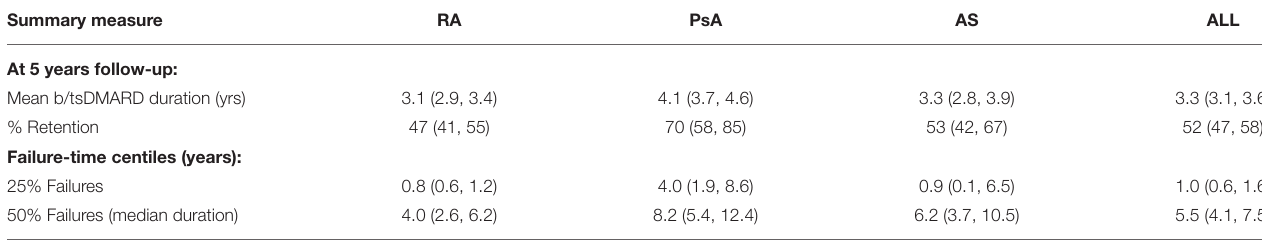
TABLE 3 | Summary measures from mean b/tsDMARD retention curves for rheumatoid arthritis (RA), psoriatic arthritis (PsA) and ankylosing spondylitis (AS) patients. Summary measure